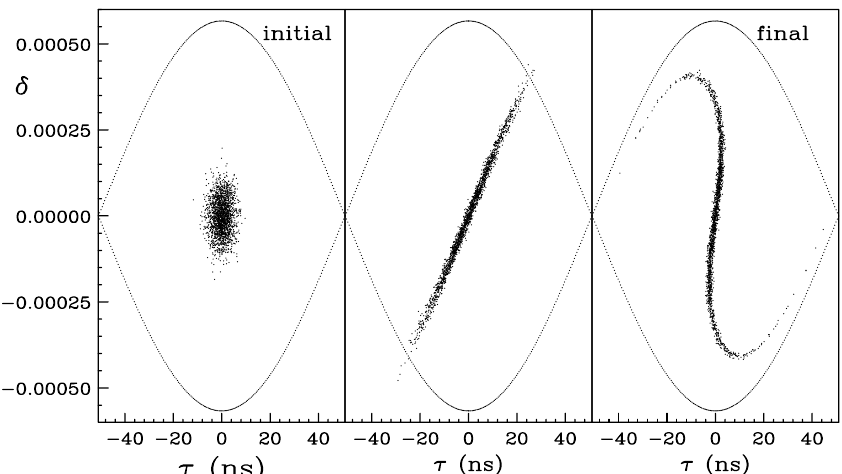
FIG. 8. Evolution of bunch population through rf phase jump. Note that the particle motion is relatively linear near the UFP. Nonlinear rf potential becomes most important when the rf phase is shifted back to the SFP. are normalized conjugate phase-space coordinates. The Hamiltonian has a SFP at (cid:2) f , P (cid:3) SFP (cid:1) (cid:2) 0, 0 (cid:3) and an UFP (cid:1) (cid:2) p , 0 (cid:3) . The synchrotron Hamiltonian at (cid:2) f , P (cid:3) UFP